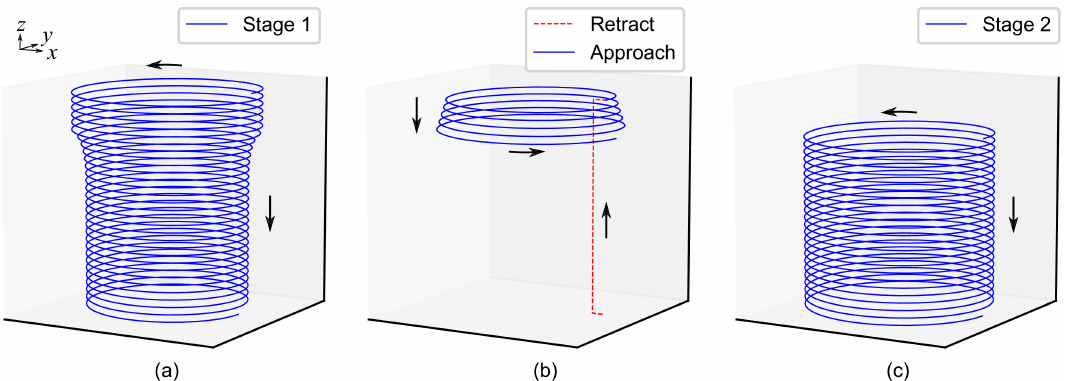
Figure 7. Schema of the tool tip trajectory for the proposed hole-flanging by SPIF in two stages: ( a ) first stage; ( b ) transition movement and ( c ) second